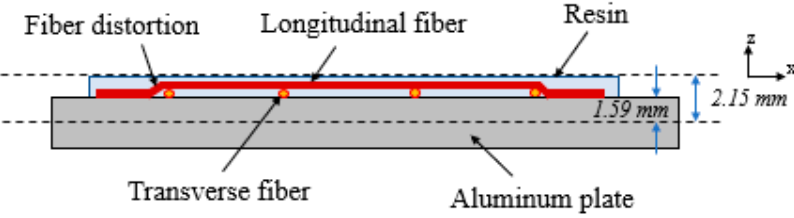
Figure 6. Side view of the aluminum beam with bonded optical fiber in a grid configuration.